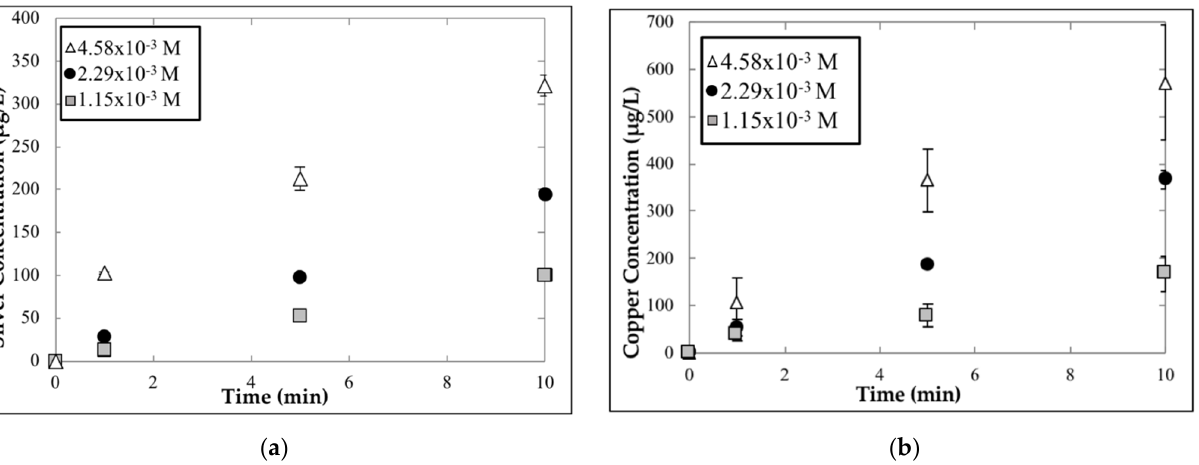
Figure 6. Metal ion concentration as a function of time in 0.4 L synthetic groundwater with various ionic strengths. ( a ) displays ion release for an apparatus with 1 mm silver wire, and ( b ) displays release for the same apparatus with copper wire: 4.58 × 10 − 3 M, 2.29 × 10 − 3 M, and 1.15 × 10 − 3 M correspond to 100% synthetic groundwater, 50% synthetic groundwater, and 50% deionized water, and 25% synthetic groundwater and 75% deionized water, respectively. The average of three trials is shown in the graph with error bars indicating the standard error between the three trials. A trendline is included for each ionic strength to depict the linear relationship of metal ion release and